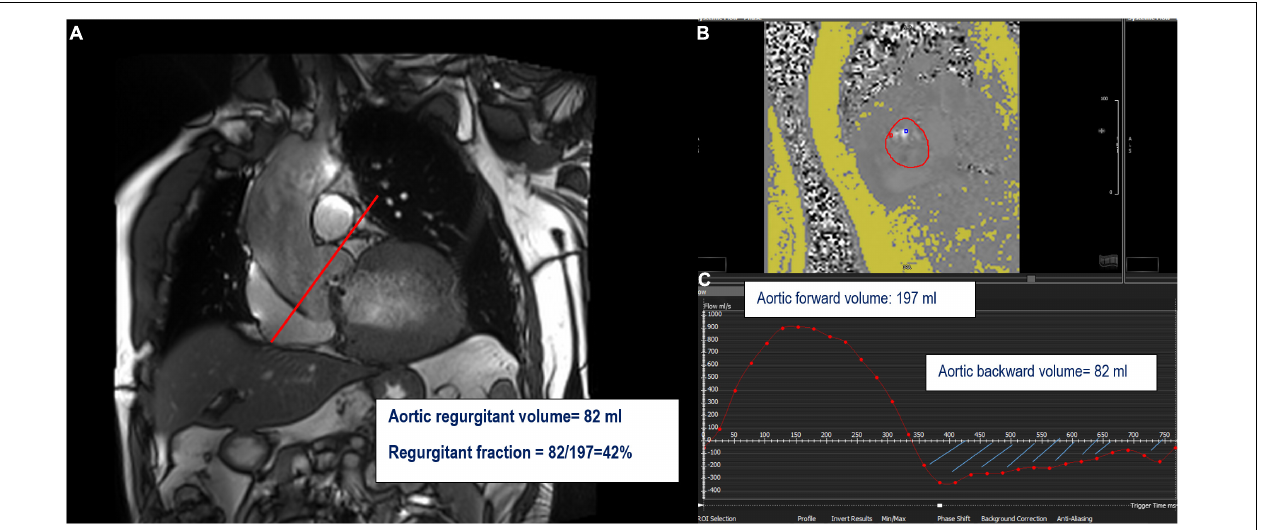
FIGURE 5 | Example of the direct quantification of aortic regurgitation by phase-contrast imaging. Perpendicular line (red) above the aortic valve on LVOT view indicating the slice position for phase-contrast velocity mapping (A) generating phase images (B) and flow curves images (C) . The aortic regurgitant volume (ARvol) is represented by the area under the diastolic flow curve (blue hatch